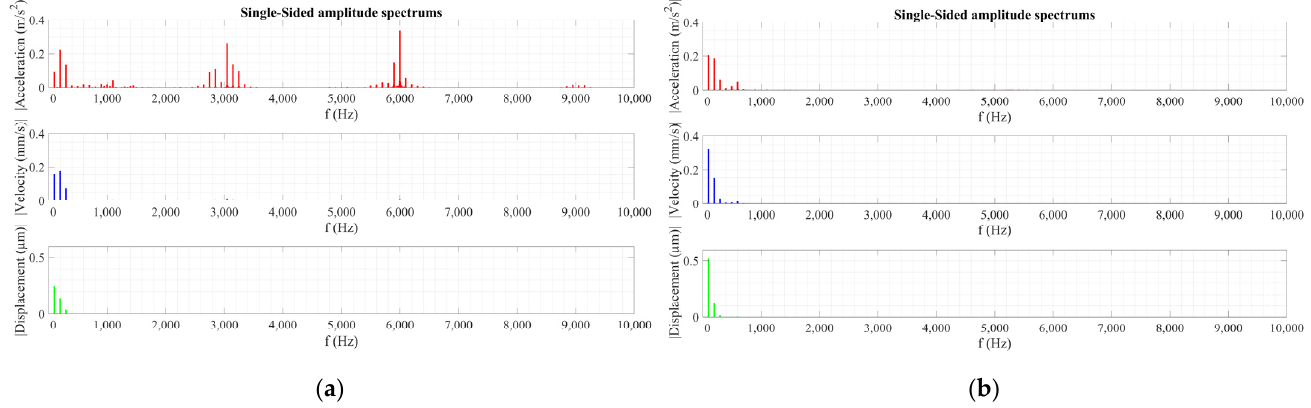
Figure 6. Single-sided amplitude spectrum of vibration acceleration, velocity, and displacement in the open-circuit test using ( a ) power converter and ( b ) regulating transformer. the open-circuit test using ( a ) power converter and ( b ) regulating